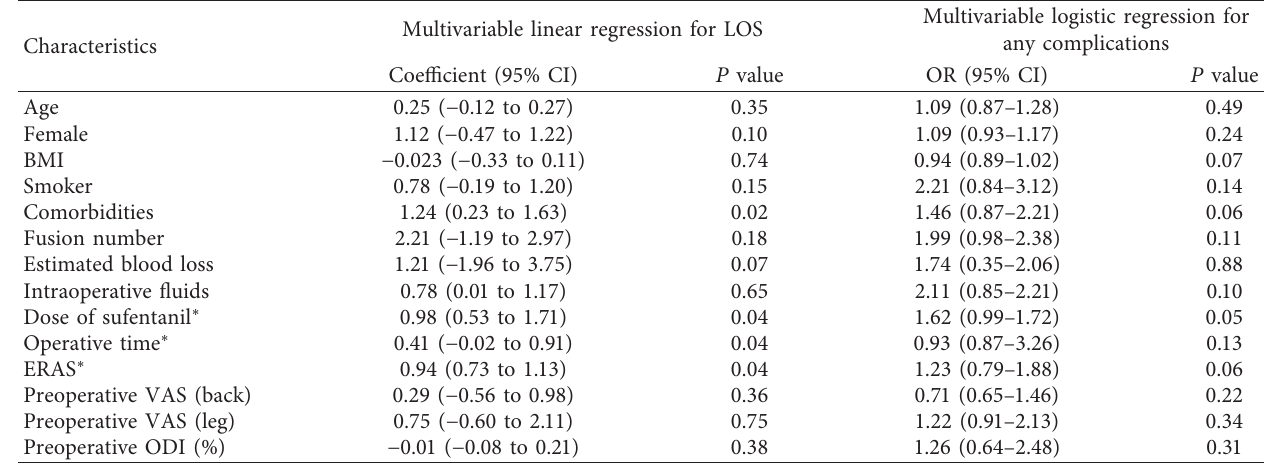
Table 4: Multivariable analyses for LOS and